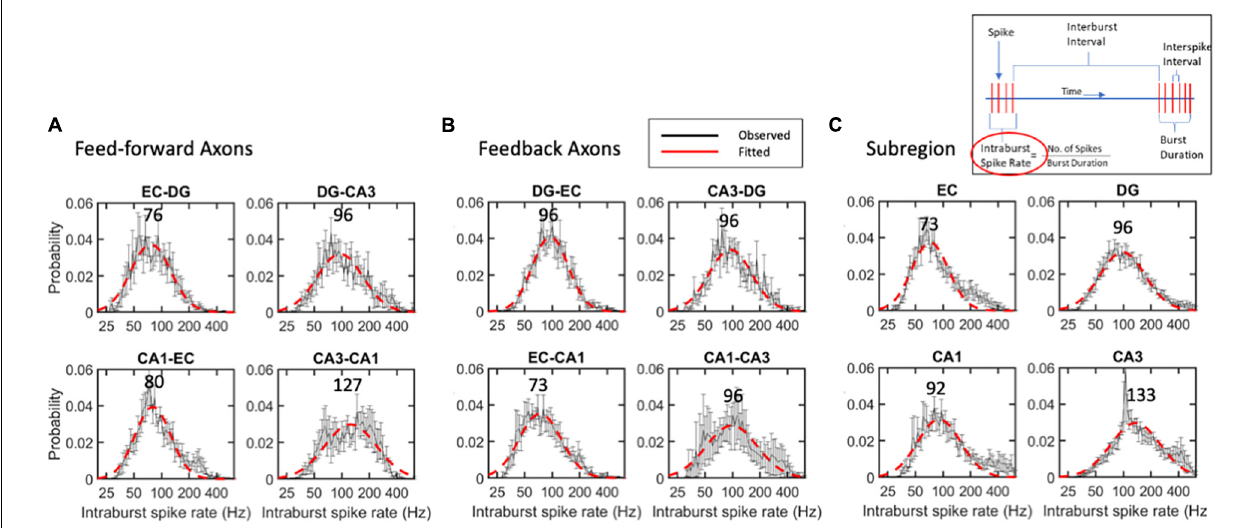
FIGURE 6 | Intra-burst spike rates follow lognormal distributions without significant differences between (A) feed-forward axons, (B) feedback axons or (C) subregions. Error bars at each intra-burst bin are SE for n = 10 arrays. Red dashed line is best fit of a single Gaussian curve. Modes in Hz are indicated above curves. No differences were seen by ANOVA with Tukey HSD. All R 2 of fits > 0.9.